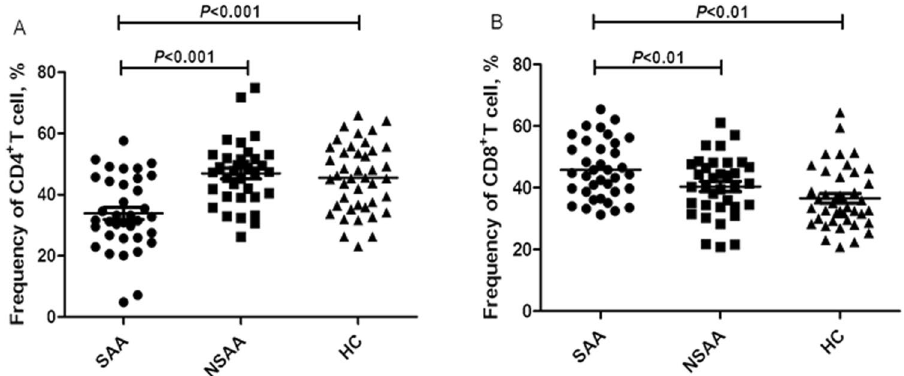
Figure 1. Frequencies of circulating T-cell subsets in patients with aplastic anaemia and the healthy controls. SAA: severe aplastic anaemia; NSAA: non-severe aplastic anaemia; HC: healthy control. ( A ) Frequencies of CD4 + T-cells in patients with SAA ( • ), patients with NSAA ( ■ ), and the HC ( ▲ ). ( B ) Frequencies of CD8 +